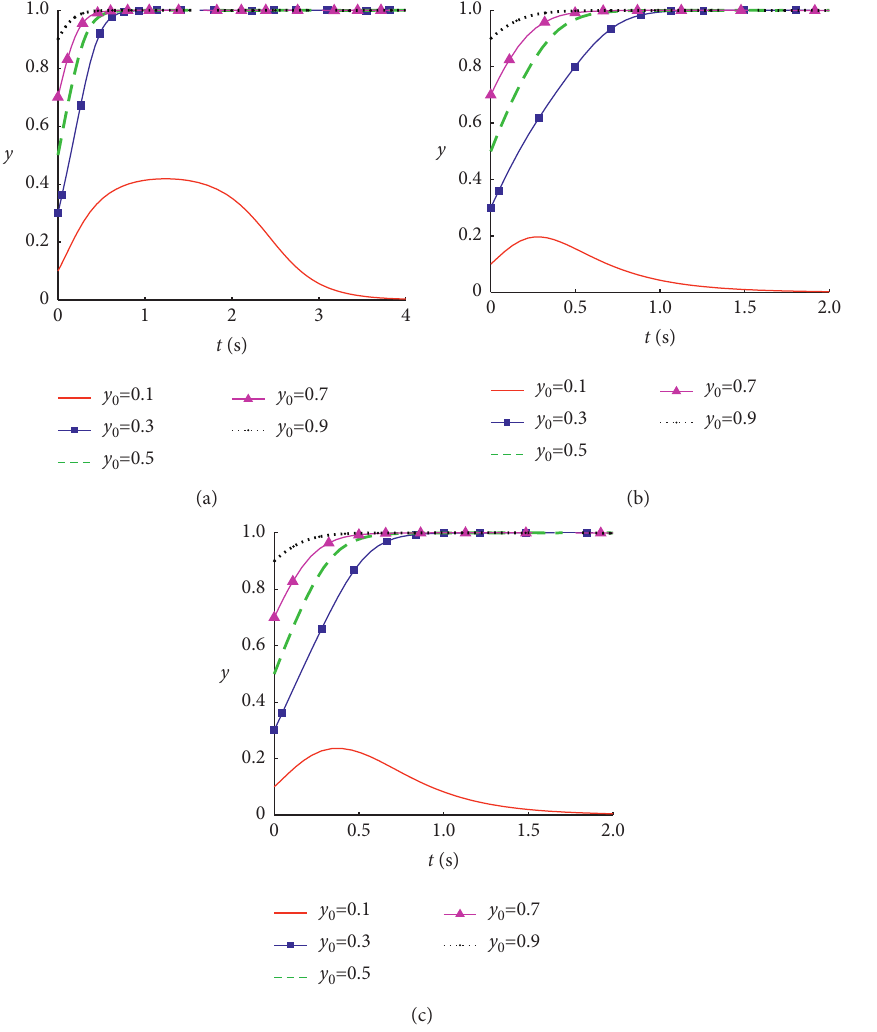
Figure 5: Evolutionary paths of the proportion of giving way strategy under different initial proportions. (a) Model 1; (b) Model 2; (c) Model